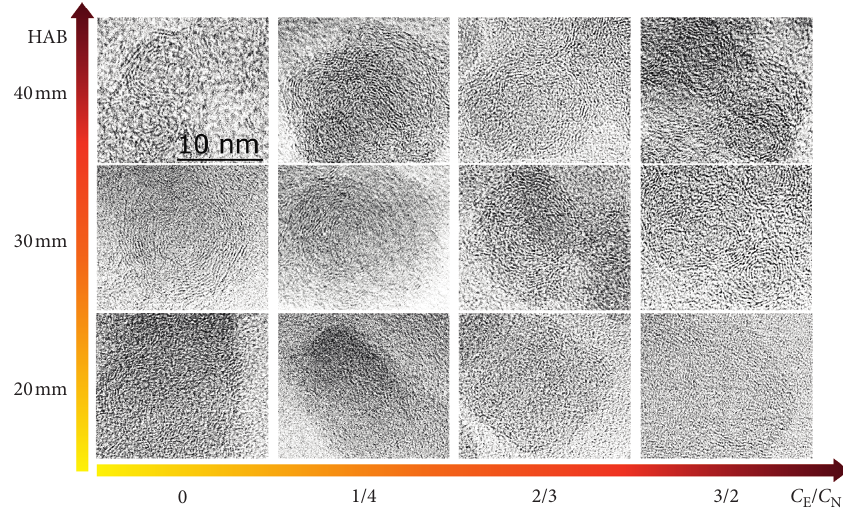
Figure 8: Nanostructure of soot particle in laminar coflow diffusion flames with n- heptane mixed with